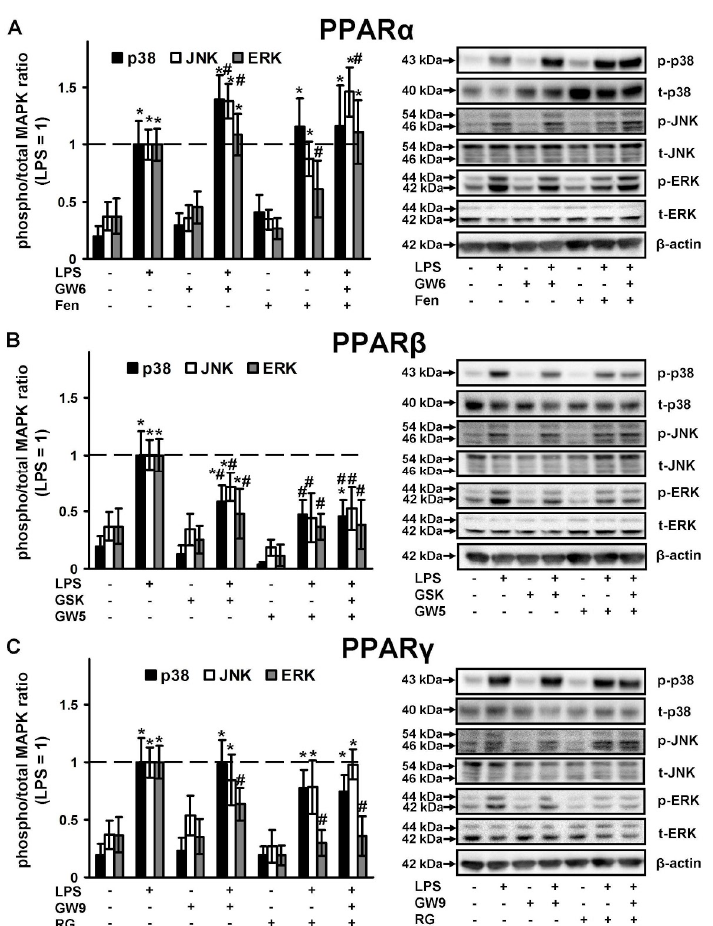
Figure 5. Comparison of p38, JNK and ERK1/2 MAPK activity in the LPS-stimulated astrocytes, treated with PPARs ligands. Astrocytes were pretreated with PPARα agonist Fenofibrate (50 μM), PPARα antagonist GW 6471 (5 μM), PPARβ agonist GW501516 (25 μM), PPARβ antagonist: GSK0660 (5 μM), PPARγ agonist Rosiglitazone (20 μM), PPARγ antagonist GW9662 (5 μM) for 30 min and then stimulated with LPS (100 ng/mL) for 4 h. p38, p-p38, pJNK, JNK, pERK1/2 and ERK1/2 protein levels were evaluated by western blotting and normalized to the loading control β-actin. Representative results are expressed as fold-changes relative to LPS-treated astrocytes. Western blots for ( A ) PPARα ligands, ( B ) PPARβ ligands, ( C ) PPARγ ligands demonstrating MAPKs protein levels. Values represent mean ± SEM from three independent experiments. * p < 0.05, compared with the unstimulated cells, # p < 0.05 compared with the LPS-stimulated